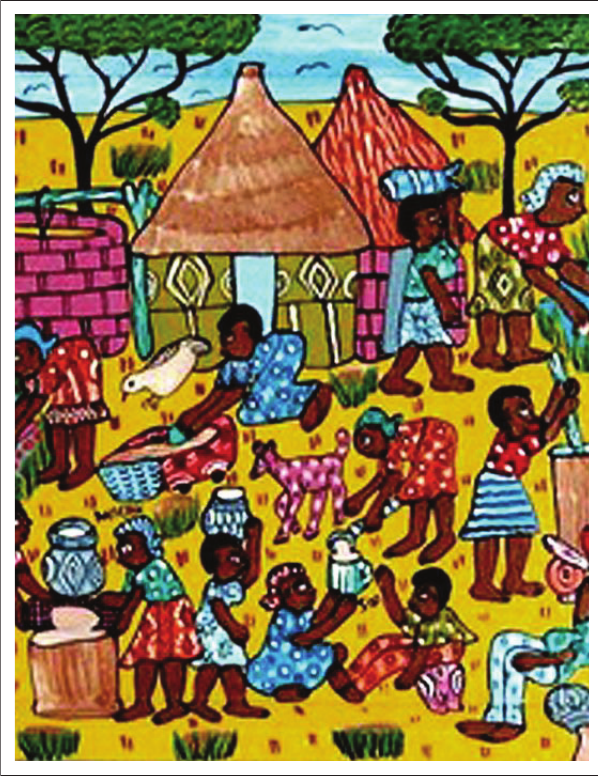
FIGURE 3: Weya women.